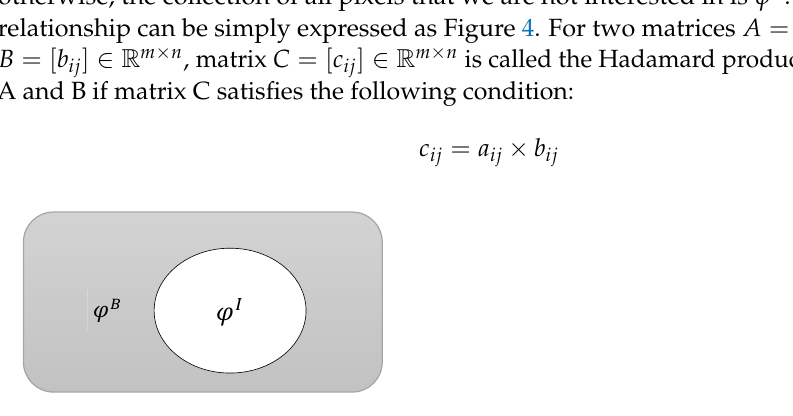
Figure 4. The distribution map of the interested domain ϕ I and background domain ϕ B .